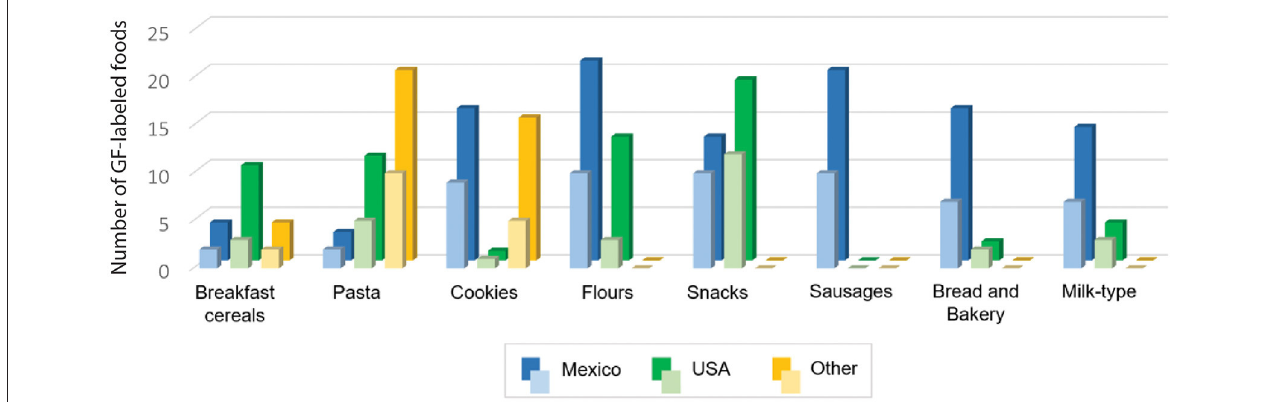
FIGURE 1 | The total number of products (bold colors) and the number of different brands of each product type (light colors), according to their country of origin.